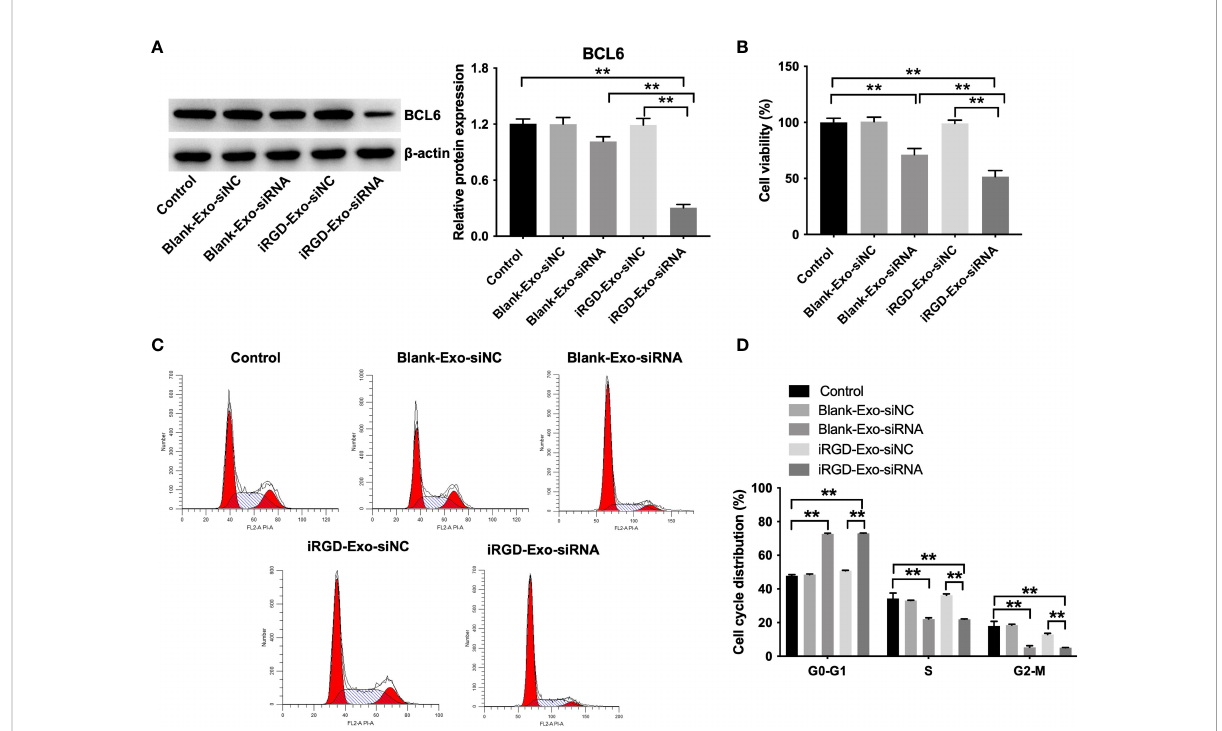
FIGURE 5 In vitro antitumor effect of iRGD-Exos-BCL6 siRNA. OCI-Ly8 cells were incubated with blank-Exo loaded with BCL6 siRNA1 or iRGD-Exo loaded with BCL6 siRNA1. (A) Western blot analysis of BCL6 expressions in OCI-Ly8 cells. (B) CCK-8 assay was used to detect cell proliferation. (C, D) Flow cytometry assay was used to detected cell cycle distribution. **P < 0.01. All tests were repeated in